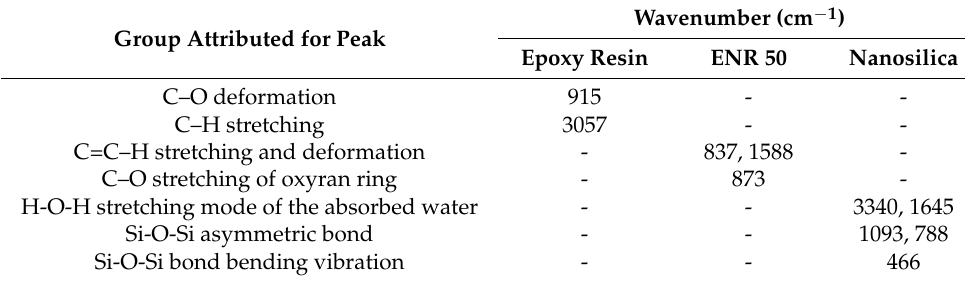
Table 1. Functional groups from the FTIR spectra of nanocomposite components.